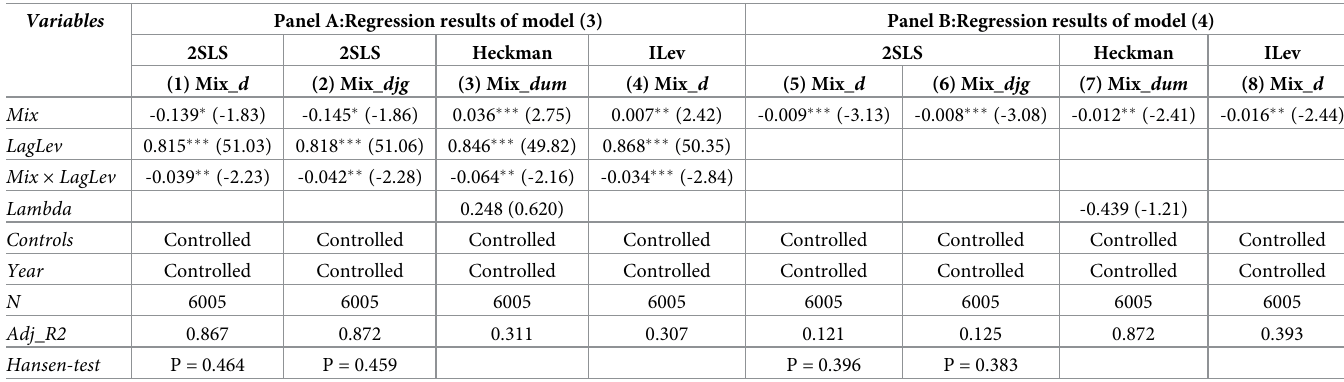
Table 11. Robustness test. Panel A:Regression results of model